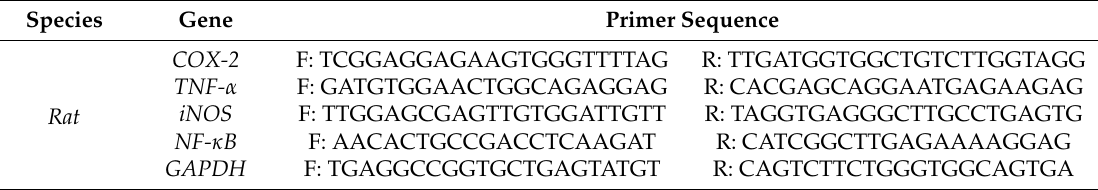
Table 4. Primers used for RT-PCR analysis. COX-2—cyclooxygenase 2; TNF- α —tumor necrosis